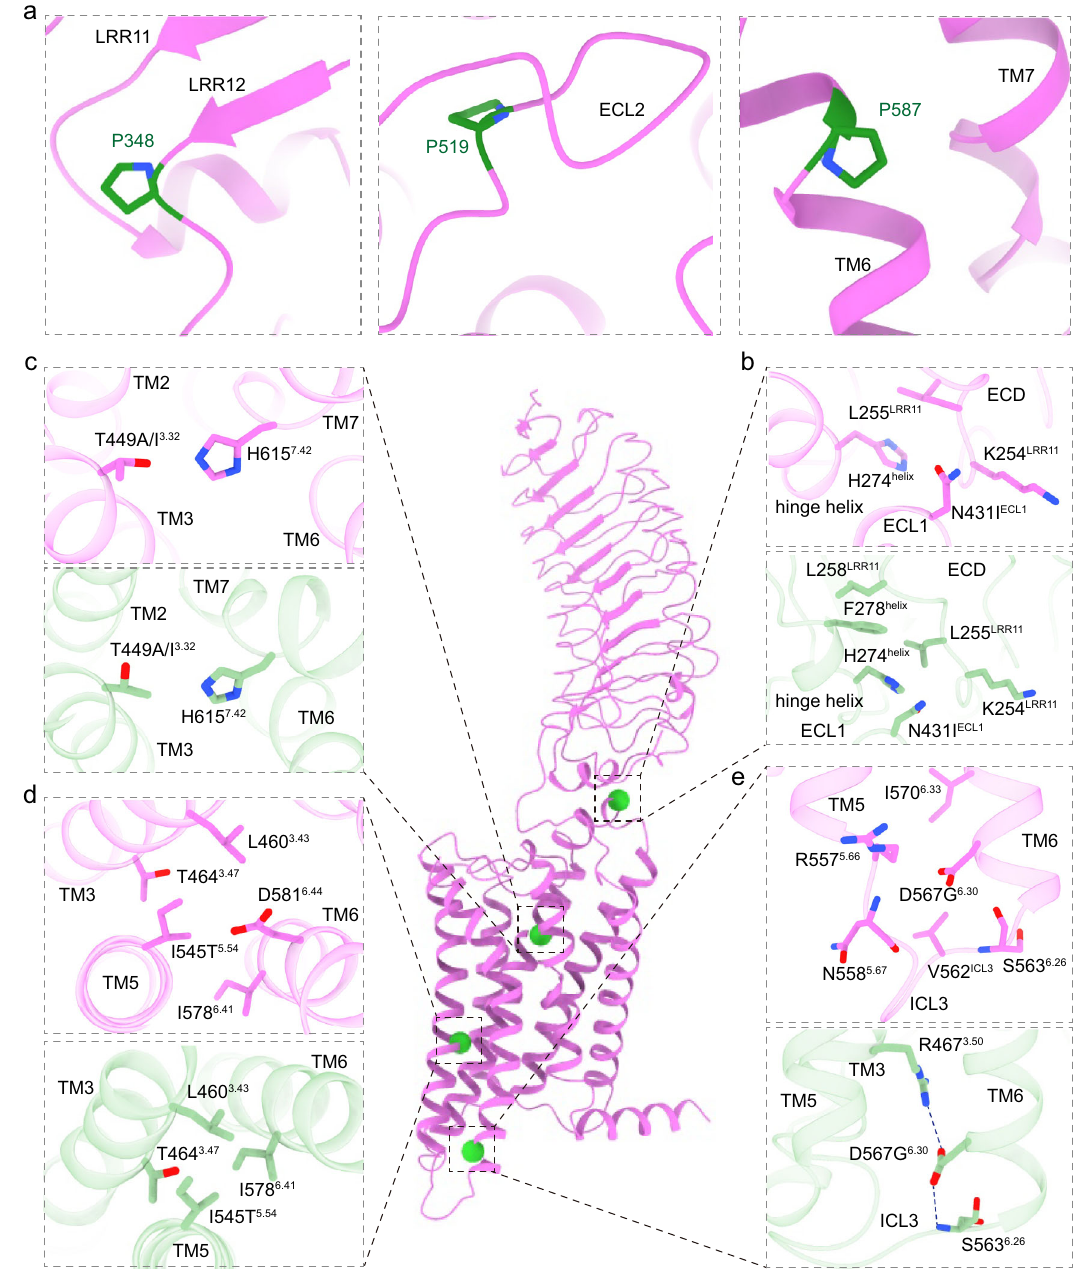
Fig. 6 | Detailed structural analysis of mutations in FSHR. a Three inactive mutationsinFSHR. b – e ThedetailedinteractionssurroundedresiduesN431I ECL1 ( b ), T449A/I 3.32 ( c ),I545T 5.54 ( d )andD567G 6.30 ( e )mutations.TheactiveFSHRstructureis